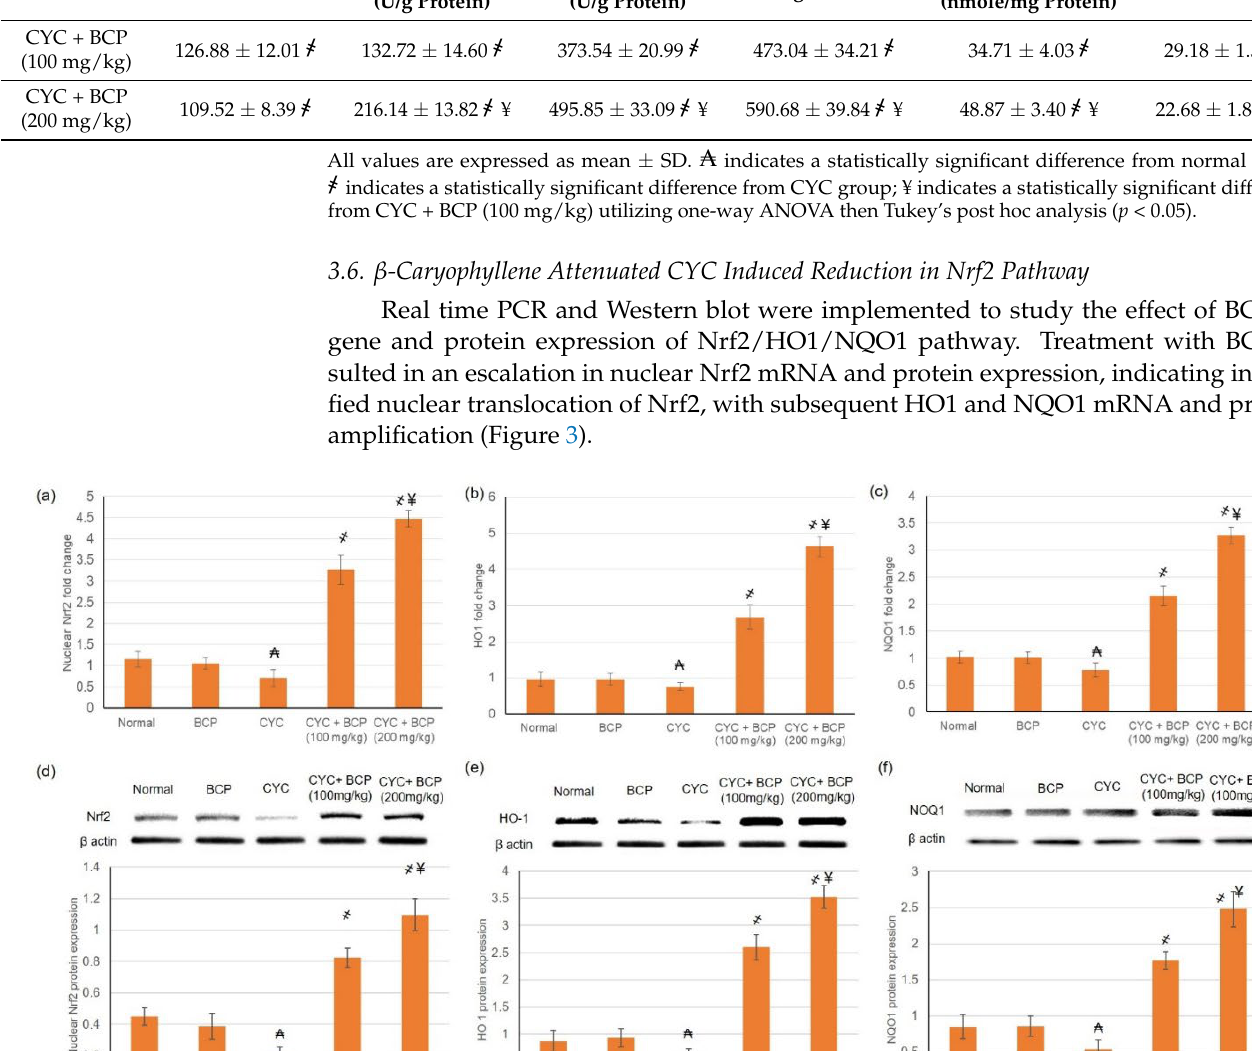
Table 1. Effects of treatment with β -caryophyllene (BCP) for 14 days on cyclophosphamide (CYC) induced fluctuations in body and heart weights and heart to body weights ratio in rat.